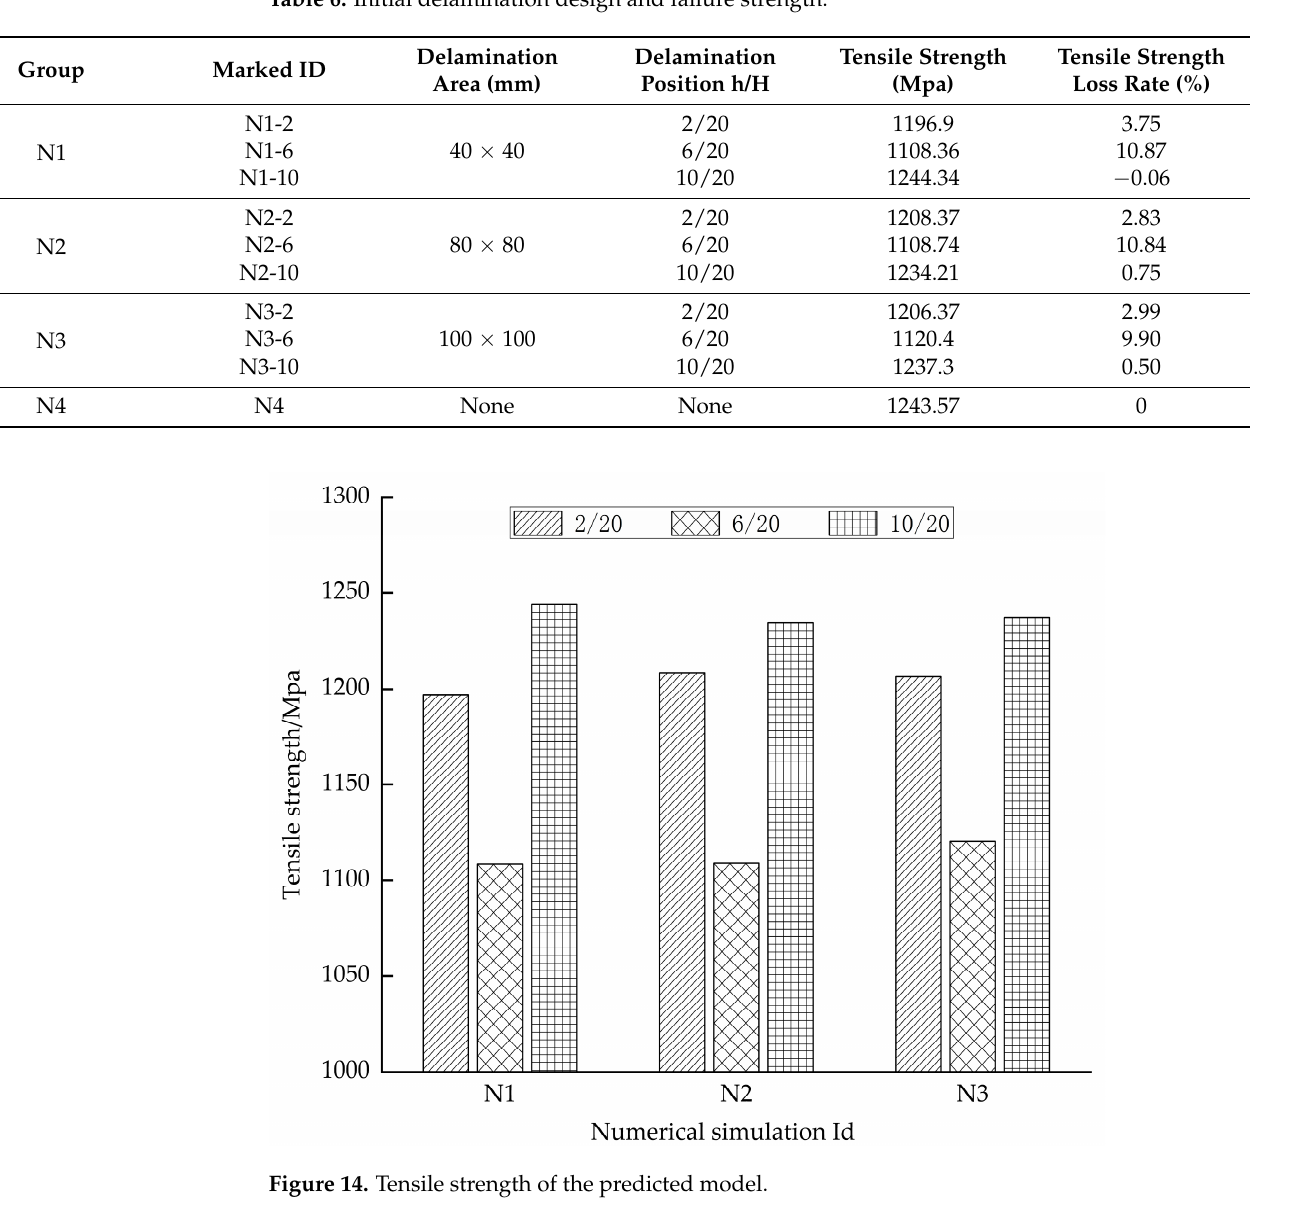
Table 6. Initial delamination design and failure strength.